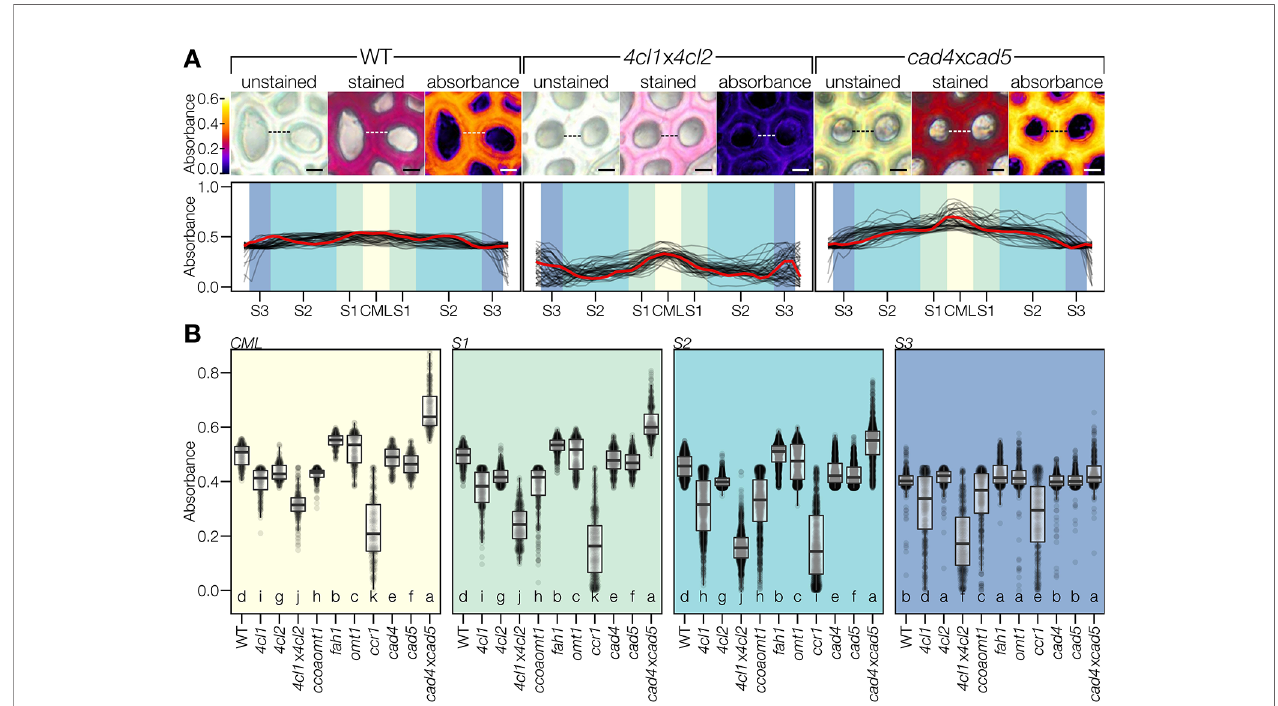
FIGURE 7 | Coniferaldehyde content varies across cell wall layers. (A) Color coded absorbance maps created by subtracting unstained absorbance from stained absorbance. Line pro fi les across the cell walls separating two adjacent interfascicular fi ber cells revealed the relative changes in coniferaldehyde incorporation between genotypes; such as in the coniferaldehyde-reduced mutant 4cl1 x 4cl2 and the coniferaldehyde over-accumulating mutant cad4 x cad5 compared to the WT. Scale bar = 5 µm. Quanti fi cation was done on 50 line pro fi les from two plants per genotype. The pro fi le indicated by the dashed line in the pictures is drawn in red in the line pro fi les. Cell wall layers, including middle lamella (CML) and secondary cell wall layers S1 – S3, are indicated by different background shading. (B) Coniferaldehyde incorporation in each cell wall layer. Each data point re fl ects one pixel in a line pro fi le. Statistically signi fi cant differences between genotypes are indicated by different letters (per panel; Kruskal – Wallis test, Holm-adjusted for multiple comparisons, a =